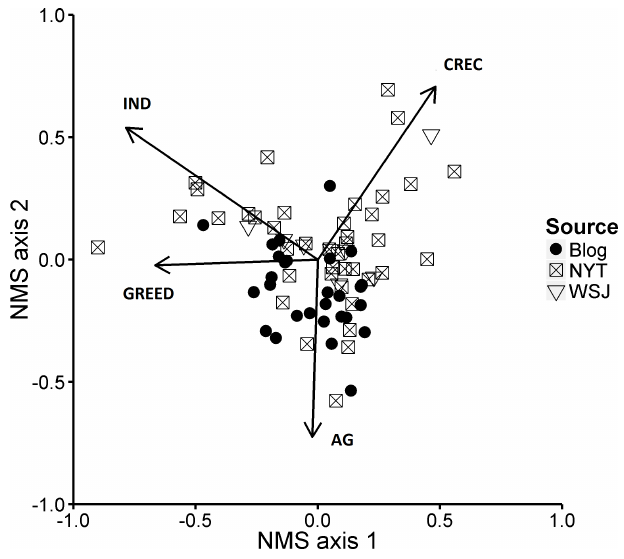
Fig. 6 . Nonmetric multidimensional scaling plot for motivations, see Appendix 1 for long form code